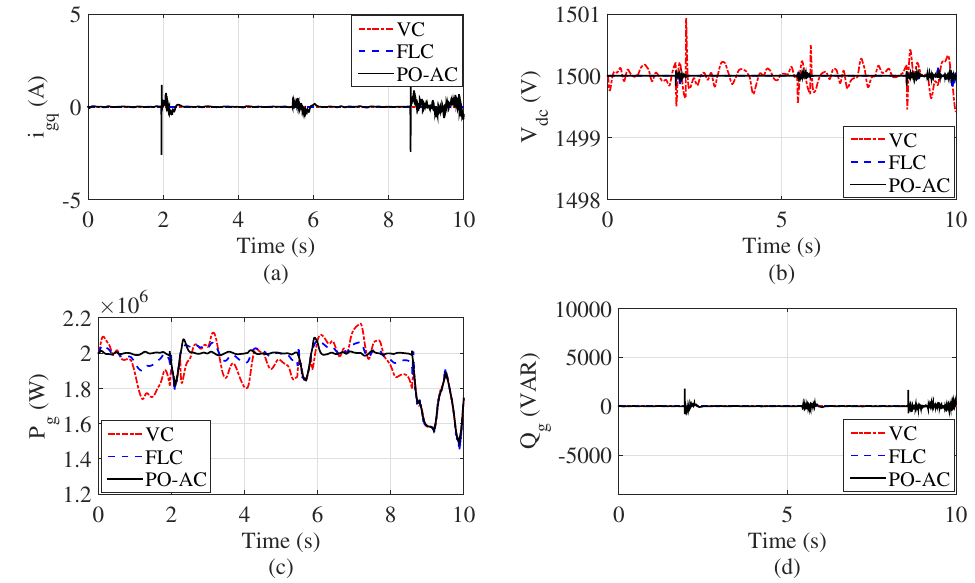
Figure 10. Responses of the grid to random wind speed. ( a ) q-axis current i gq . ( b ) DC-Link Voltage V dc . ( c ) Active power of grid P g . ( d ) Reactive power of grid Q g